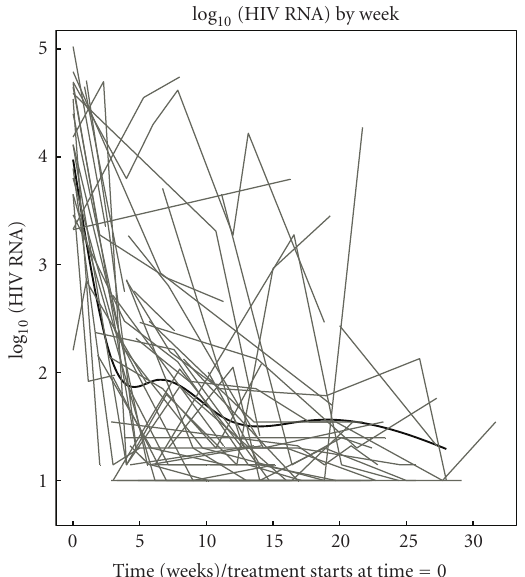
Figure 1: Kinetics of the plasma HIV RNA in pregnant women on HAART. Data were derived from 76 pregnant women who initiated or reinitiated HAART during pregnancy. 0 weeks indicates the beginning of therapy. Grey lines represent individual plasma HIV RNA trajectories. The black line represents the population curve generated by the mixed-model analysis. The predictions of the model were confirmed by additional analyses which showed that at 4 weeks of HAART, 42% of mothers had < 100 HIV RNA copies/mL of plasma; at 12 weeks, 42% had < 50 copies/mL; and at 24 weeks, 56% had < 50copies/mL. However, it should be noted that the model’s estimated rise between 5 and 7 weeks is likely not